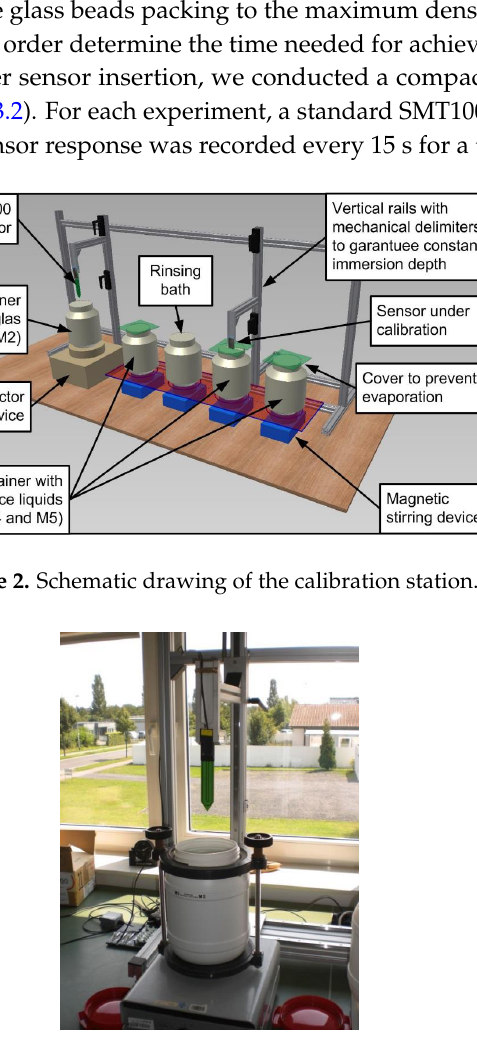
Figure 3. The container with glass beads (M2) on top of the vibration machine.